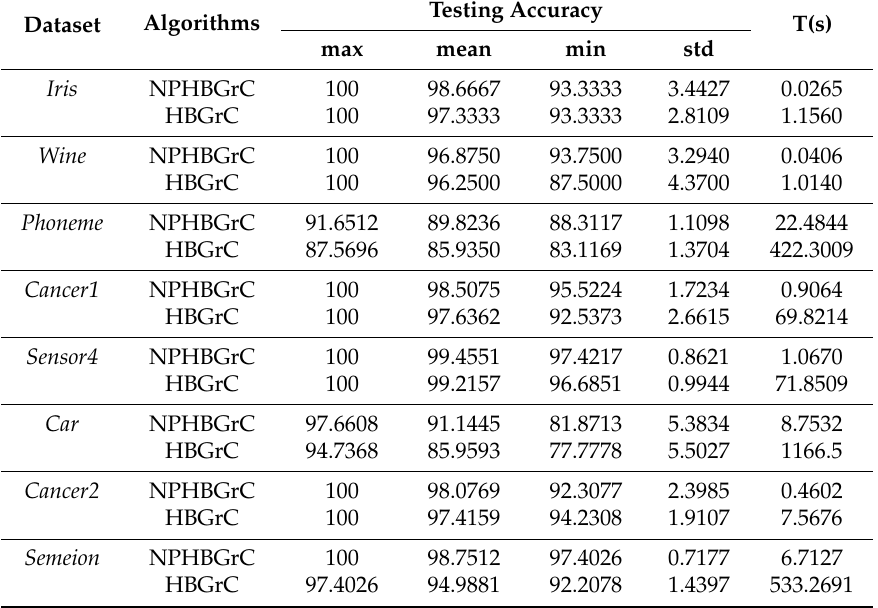
Table 3. The performances in N -D